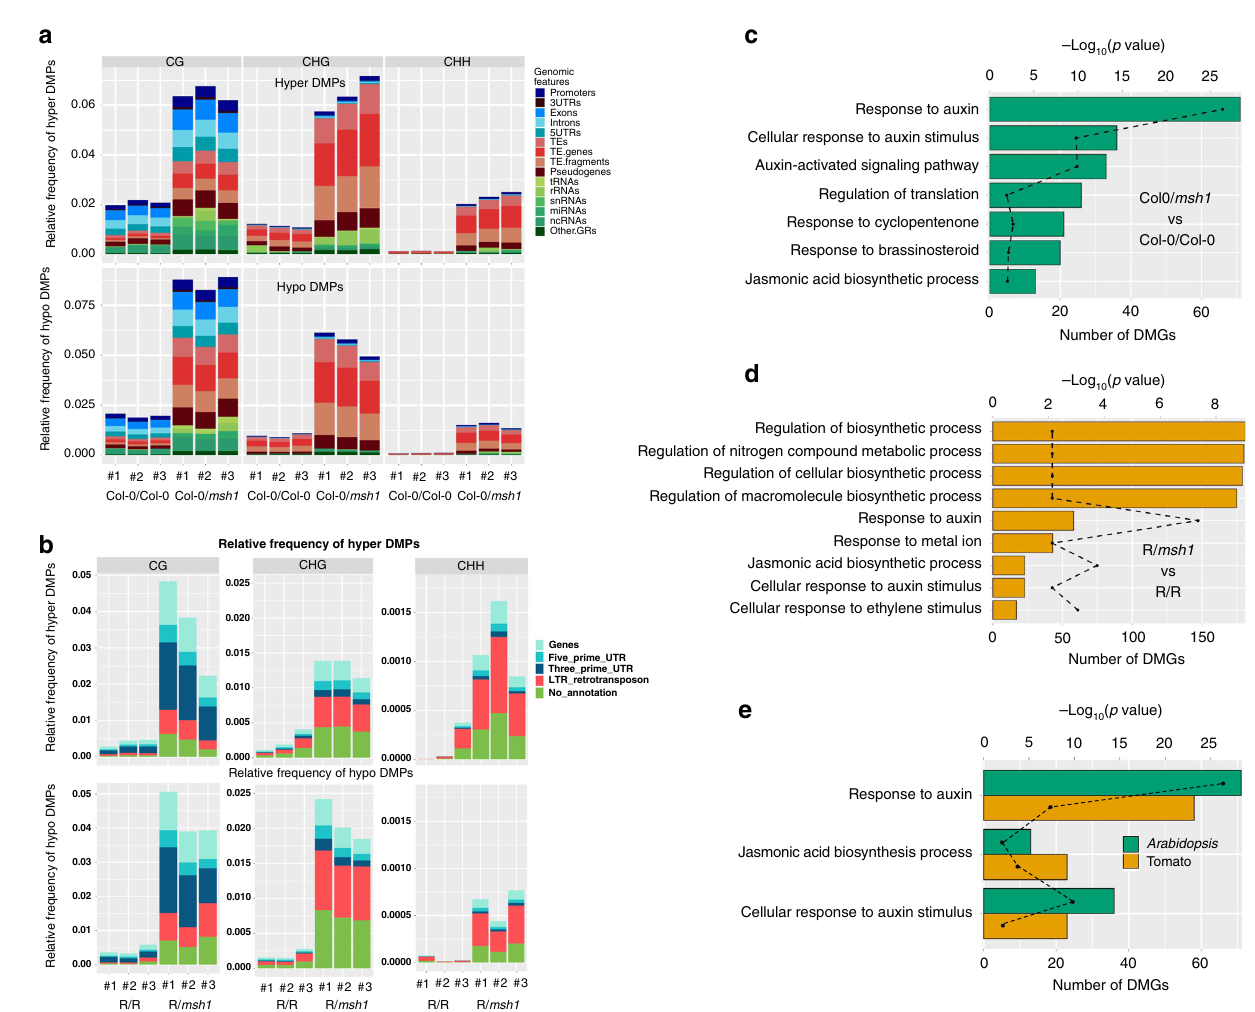
Fig. 3 Differentially methylated position genomic distribution and enriched differentially methylated gene networks in graft progenies. a The relative frequency of differentially methylated positions (DMPs) in each graft progeny plant over genic regions (blue shades), TE-related regions (red shades), and others (green shades). The average of three control plants (the centroid of Col-0/Col-0 graft progenies) was used as reference. The relative frequency of DMPs in each genomic feature were estimated as the number of DMPs divided by the number of total genomic cytosine positions in each genomic feature. DMP number and frequency of each individual was computed separately and the group means for Col-0/Col-0 graft progenies and Col-0/ msh1 graft progenies are presented. Upper part of the graph shows the distribution of hyper DMPs, the lower part shows the distribution of hypo DMPs. b The relative frequency of DMPs in each graft progeny plant over genic regions (blue shades), LTR retrotransposon regions (red shades), and others (green shades). The average of three control plants (the centroid of Rutgers/Rutgers graft progenies) was used as reference. The tomato LTR retrotransposon annotation was acquired by using LTRpred version 1.1.0. 69 Networks identi fi ed by Network Enrichment Analysis Test (NEAT) for the DMGs identi fi ed in c Arabidopsis graft progeny (Col-0/ msh1 vs. Col-0/Col-0); d tomato graft progeny (R/ msh1 vs. R/R); e three networks shared by both Arabidopsis and tomato graft progenies. Bar graph represents number of differentially methylated genes (DMGs) and dotted line represents − log 10 ( p -value) of the enrichment test. c – e p -values were computed using one-sided hypergeometric distribution test as implemented in NEAT (R package version 1.1.3). Source data are provided as a Source Data fi